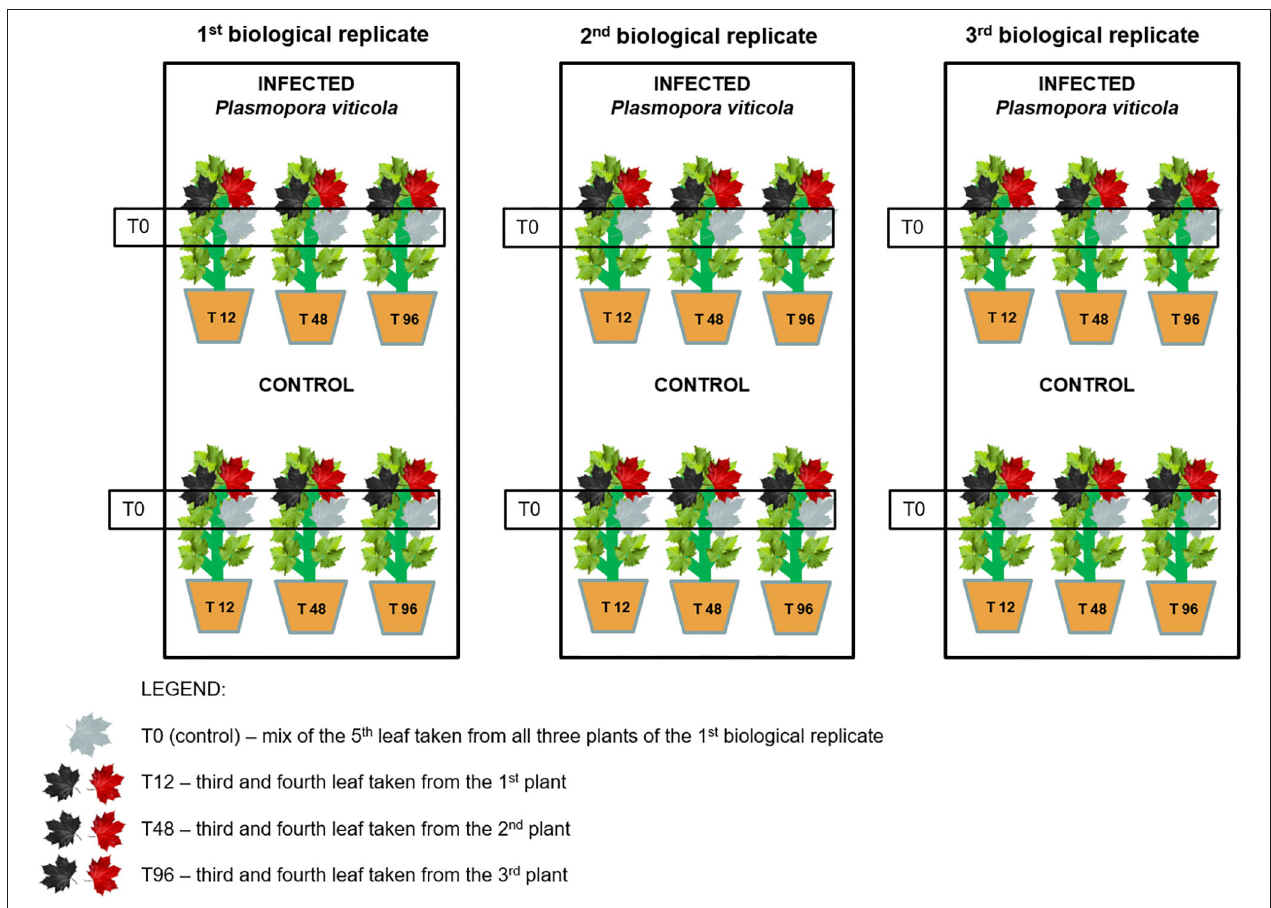
FIGURE 1 | Experimental design and randomization